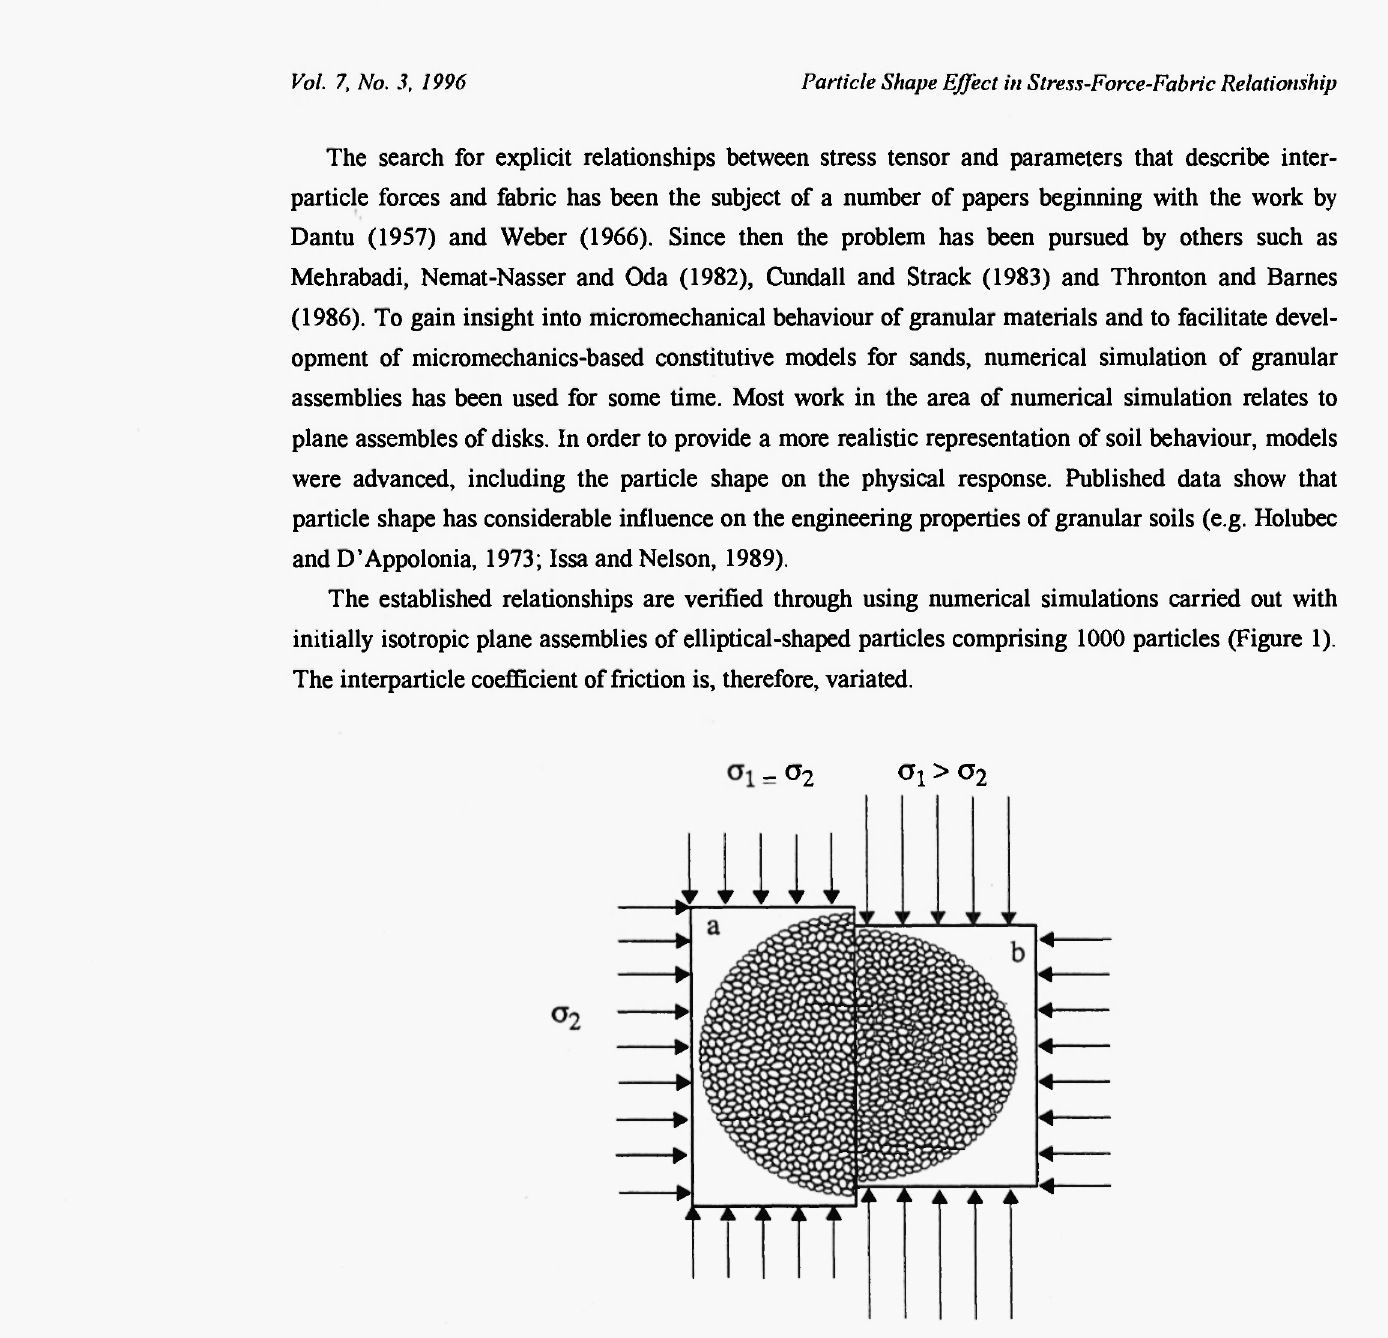
CONTACT NORMALS, CONTACT VECTORS AND CONTACT